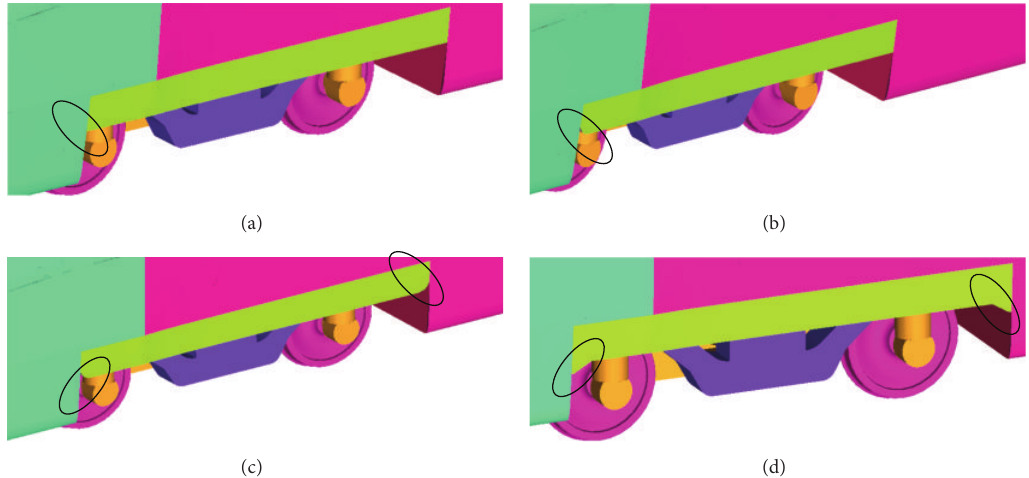
Figure 32: The geometric models of the four bogie skirt board designs: (a) Qb1, (b) Qb2, (c) Qb3, and (d)